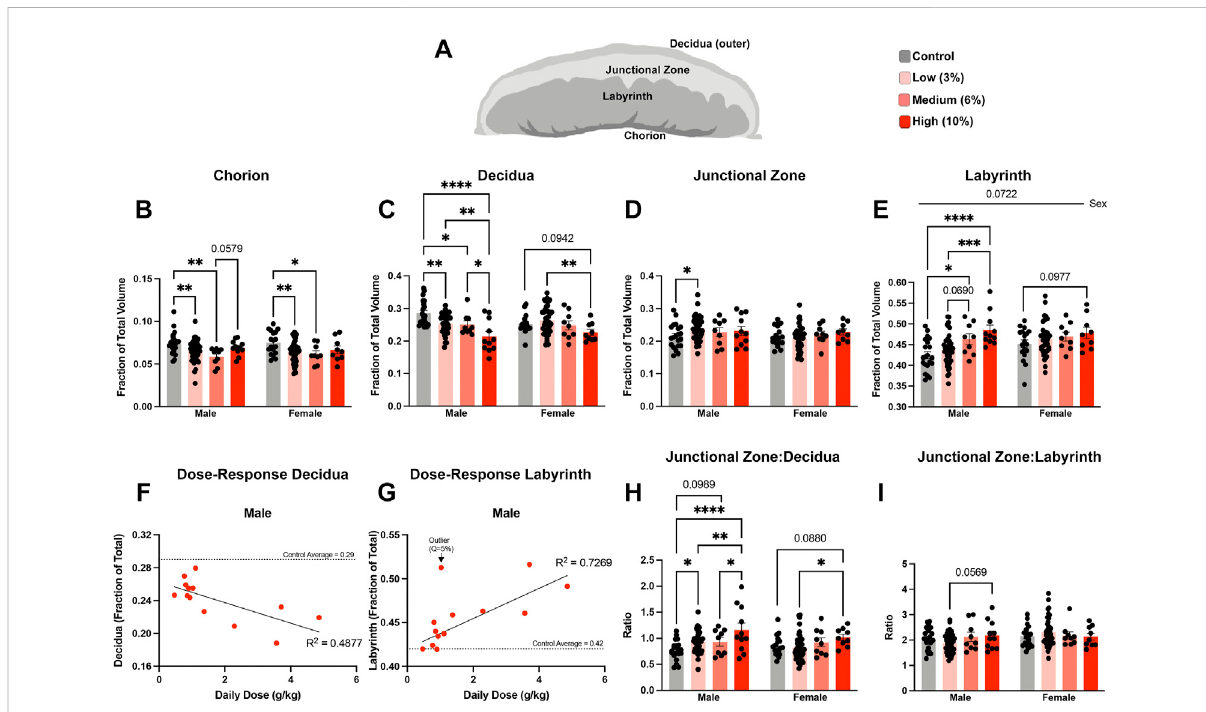
FIGURE 6 Chronic paternal alcohol exposures induce dose- and sex-speci fi c changes in the histological organization of the placenta. (A) Schematic diagramdepictingthelayersofthemurineplacenta. UsingmicroCT,weconductedavolumetricanalysisofeachplacental layerandusedatwo-way ANOVA to compare measures between male and female offspring across treatment groups. Volumes for the (B) chorion, (C) decidua, (D) junctional zone, and (E) labyrinth are expressed as a ratio of the total placental volume ( n = fetus, randomly selected from each litter, males: 21 Control, 43 low, 9 Medium, 11High; females: n = 18 Control, 42 Low, 9 Medium, 9 High). Pearson correlation analysis contrasting proportional volume of the (F) decidua and (G) labyrinth with sire daily ethanol dose ( n = 13 averaged individuals at each absolute daily dose). Ratios comparing